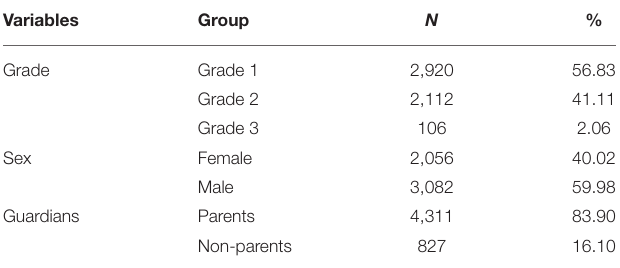
TABLE 1 | Demographic characteristics ( N =